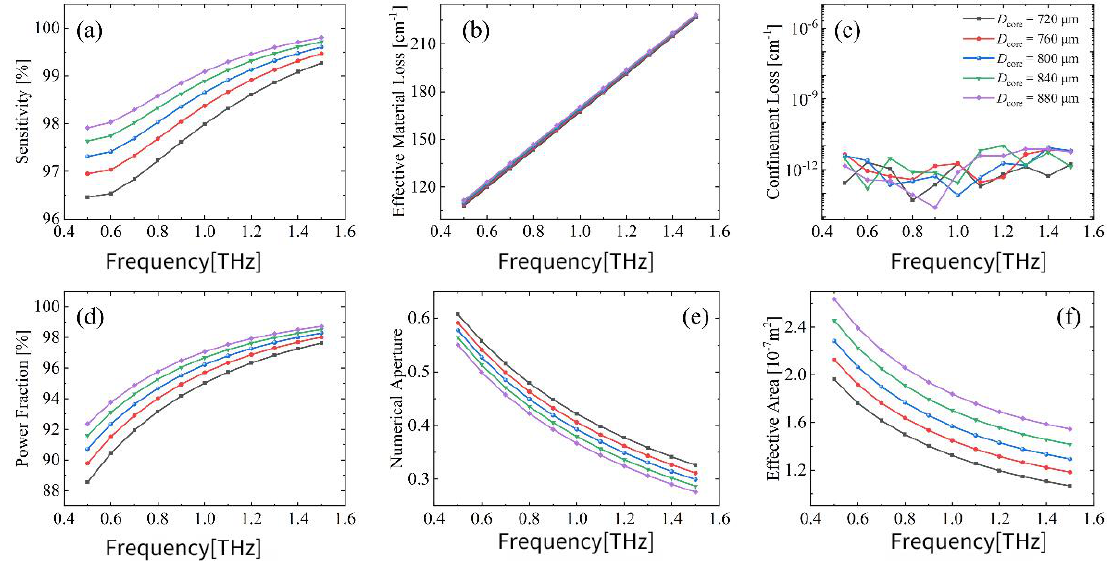
Figure 4. Behavior of ( a ) sensitivity, ( b ) EML , ( c ) CL , ( d ) core power fraction, ( e ) NA , and ( f ) A eff with respect to frequency for different core diameters. respect to frequency for different core